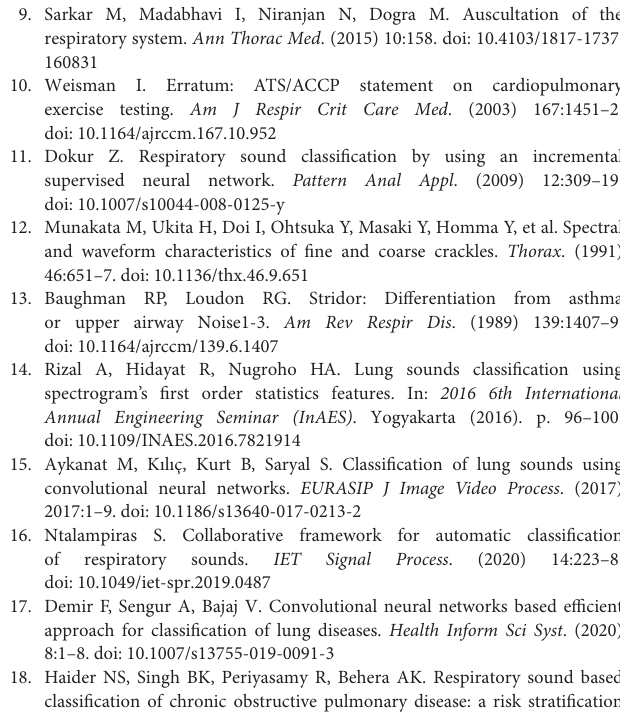
abnormal RS concurrently 1.00% accuracy gained through the AlexNet